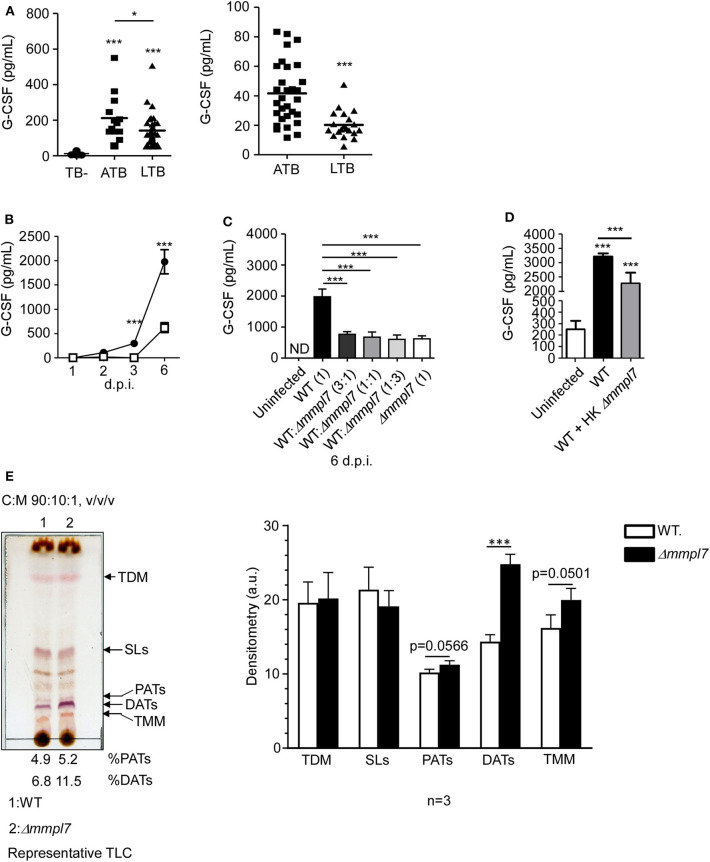
Δmmpl7 mutant Mtb overexpresses DATs and limits cytokine production in lung epithelial cells: (A) Serum samples from human active TB patients and controls (Left) Panel: Mexico (TB- n = 30; ATB n = 13; LTB n = 33), Right Panel: South Africa (ATB n = 30; LTB n = 20) were analyzed for G-CSF levels. Mouse lung epithelial cells (n ≥ 4 per group) were infected with Mtb Erdman WT or Δmmpl7 at (B) MOI = 1 or MOI = 5, respectively, for indicated time points. (C) Mouse lung epithelial cells (n = 4) were infected with Mtb Erdman WT and/or Δmmpl7 at indicated ratios for a constant total MOI = 1. (D) Mouse lung epithelial cells (n = 4) were infected with Mtb Erdman WT with or without the addition of heat-killed (HK) Δmmpl7. (A–D) Supernatants were collected and G-CSF concentration was quantified by ELISA. (E) Total lipids from Mtb Erdman WT or Δmmpl7 were obtained from freshly grown bacteria (3 independent times) and extracted with chloroform:methanol (2:1, v/v/) after normalization by total bacterial number. Total lipids (100 μg) were analyzed by TLC using as a solvent system (chloroform:methanol:water, 90:10:1, v/v/v) and 10% sulfuric acid in ethanol as a developer to visualize total lipid contents (representative experiment shown). Densitometry analyses of the observed lipids were performed using the NIH software ImageJ, n = 3 (where each value corresponds to independent extractions from freshly grown bacteria and TLCs). Human cohort study groups were compared by 1-way ANOVA with Tukey's post-test, or unpaired Student's t-test, respectively. Infected groups comparing WT Erdman and Δmmpl7 Mtb strains under indicated conditions at individual time points were compared using 1-way ANOVA with Tukey's post-test or unpaired Student's t-test. TLC densitometry was analyzed by unpaired Student's t-test. *p < 0.05, **p < 0.01, ***p < 0.001.